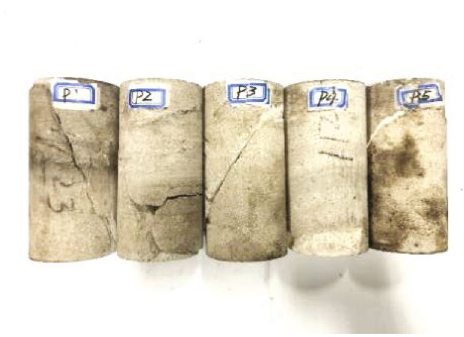
Figure 2: Broken samples. Table 1: Rock parameters of damage constitutive